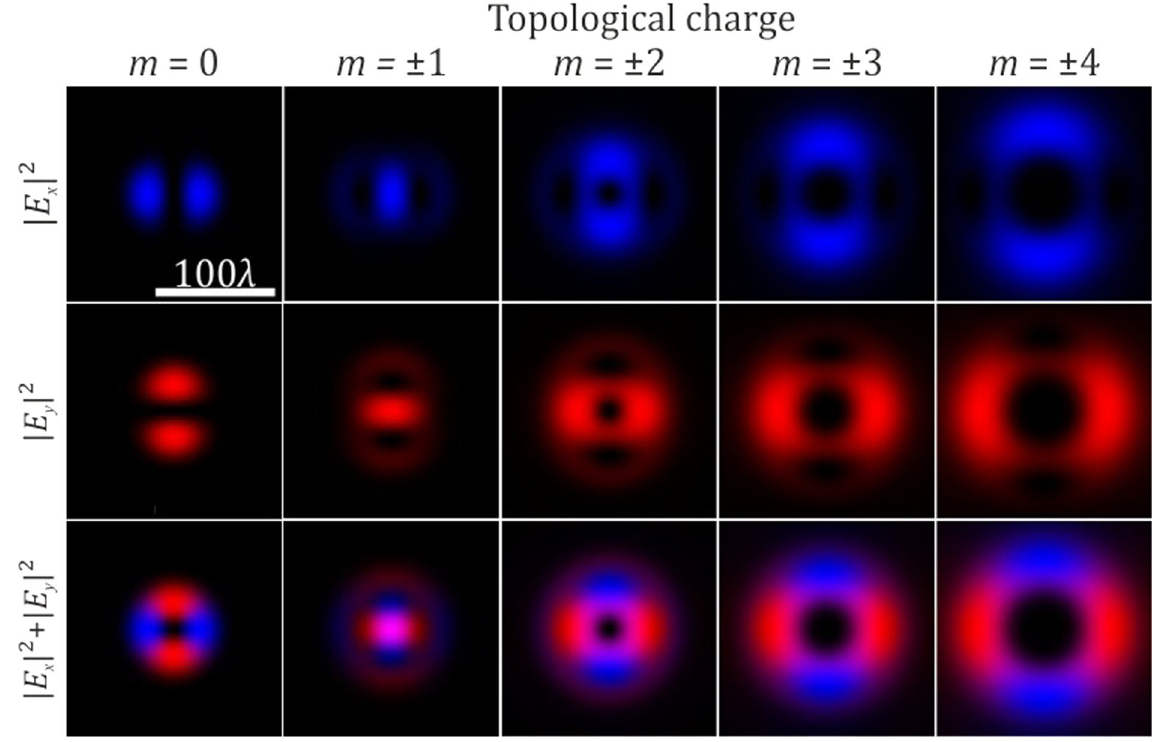
Figure 2. The distribution of the various components of the electric field in the focal plane for a radially polarized incident beam in the absence and presence of a vortex phase (the x-component is blue and the y-component is